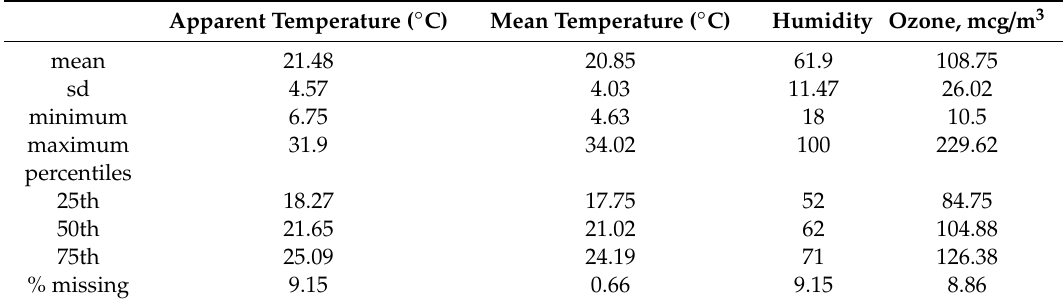
Table 1. Environmental variable statistics.